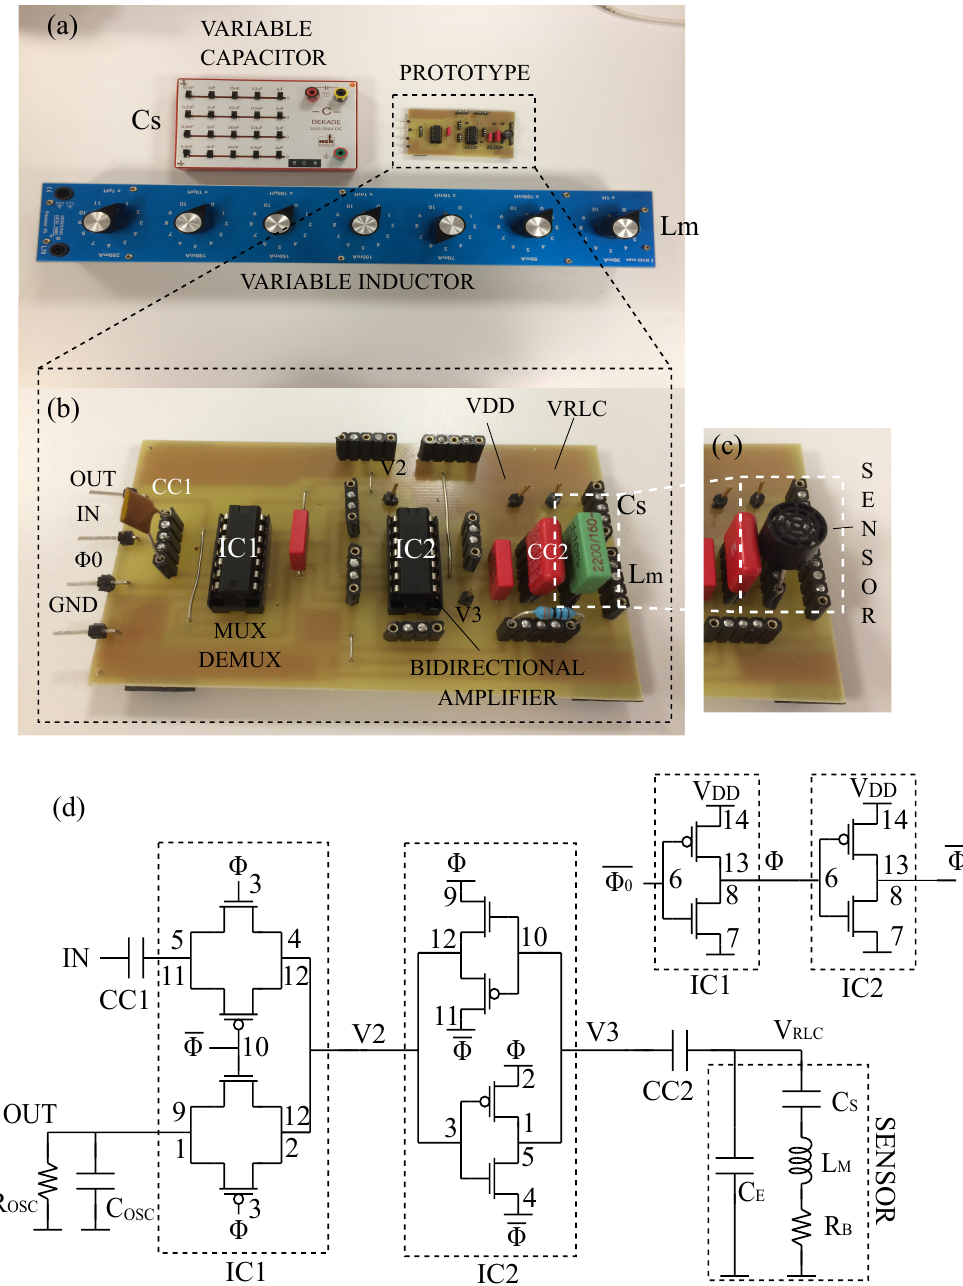
Figure 21. Measurement set-up and prototype. ( a ) measurement set-up; ( b ) prototype of the bidirectional amplifier; ( c ) prototype loaded with a piezoelectric sensor; ( d ) schematic and connections to implement the bidirectional